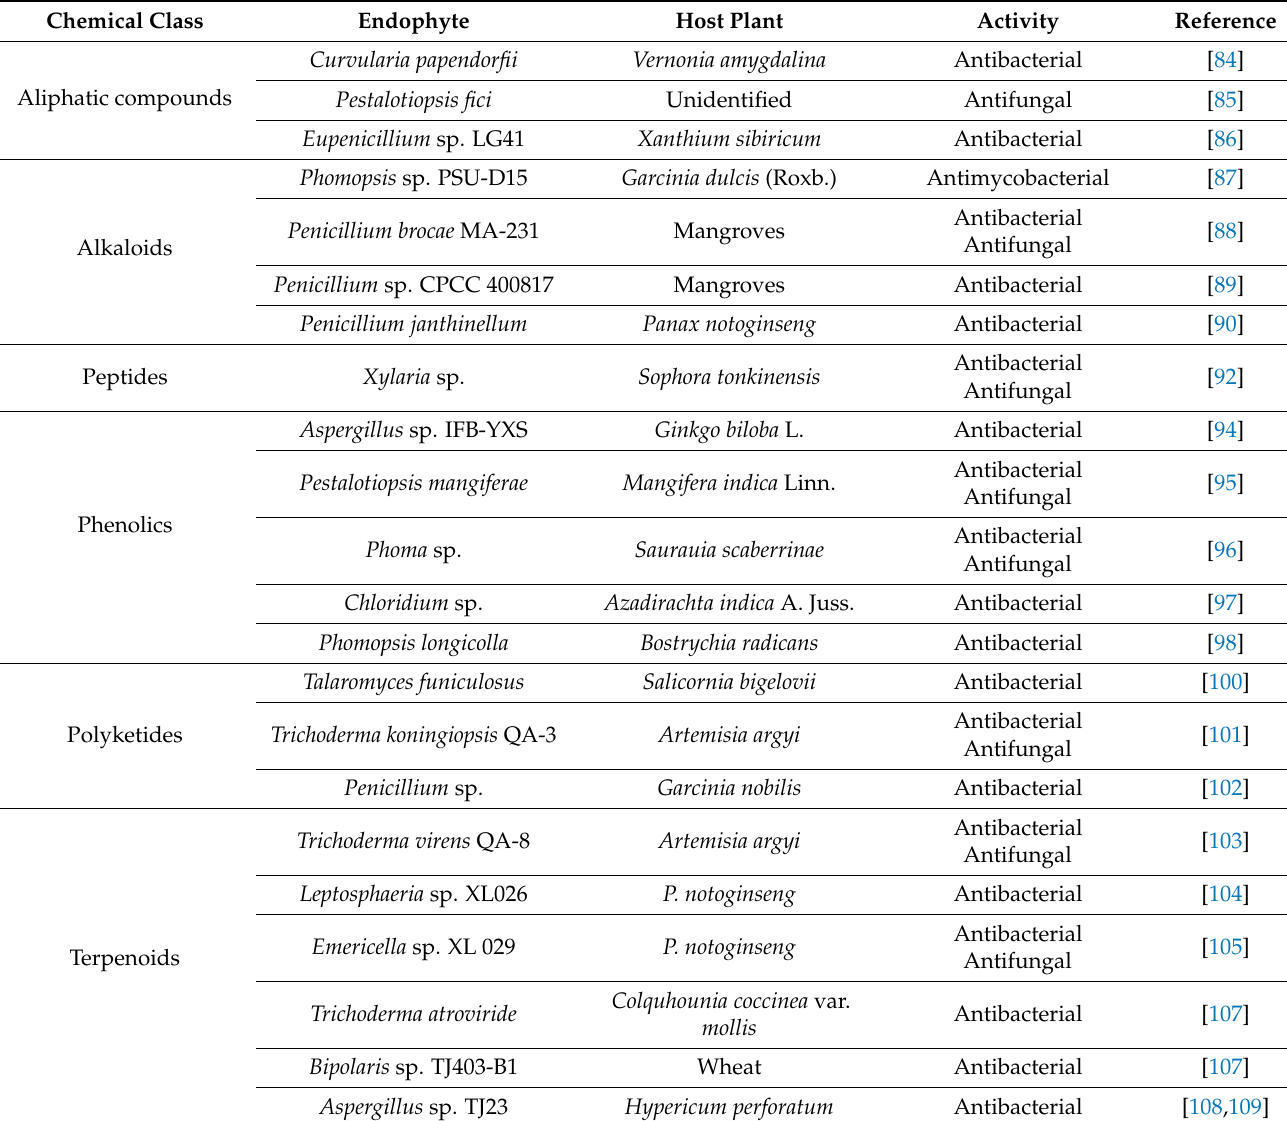
Table 2. List of newly discovered antimicrobial compounds isolated from endophytic